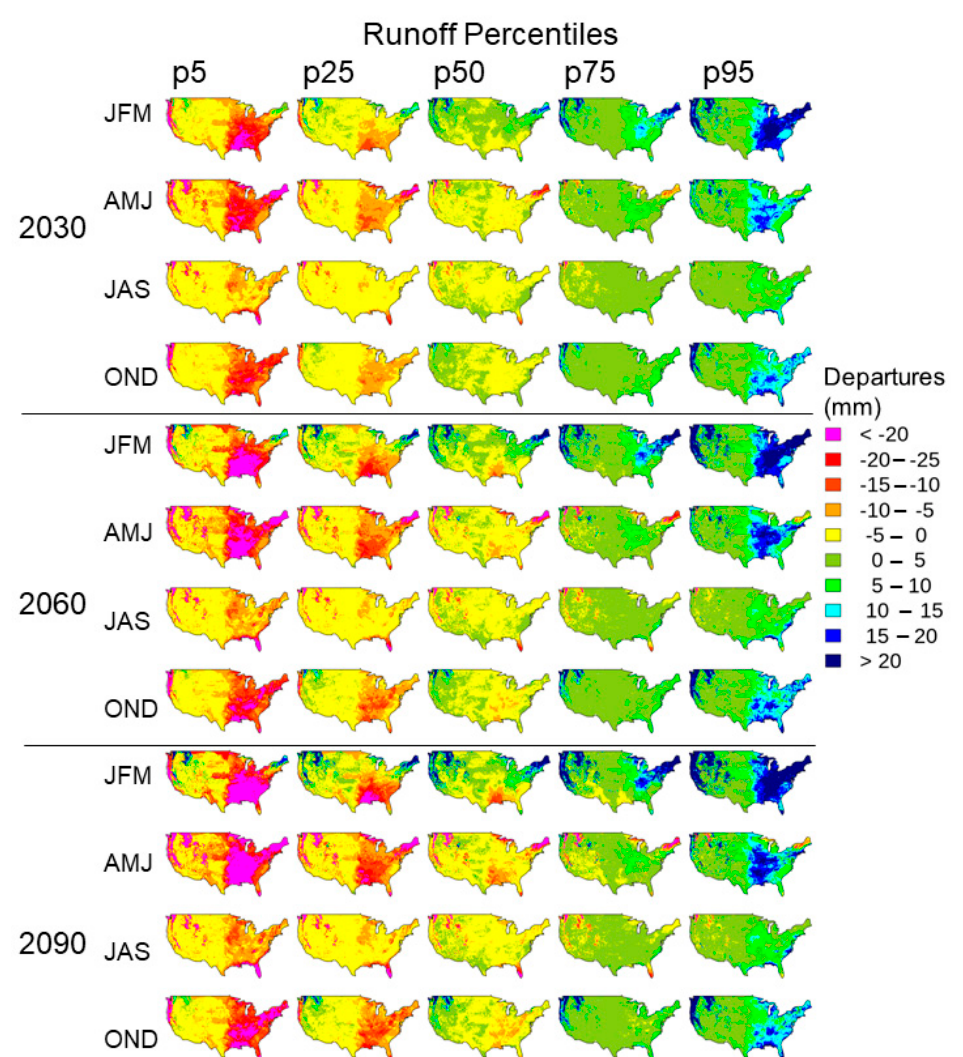
Figure 5. Departures in seasonal average monthly runo ff in millimeters (mm) by percentiles (5th, 25th, 50th, 75th, and 95th) projected for 2030, 2060, and 2090 from 214 climate simulations. JFM, January–March; AMJ, April–June; JAS, July–September; OND, October–December.